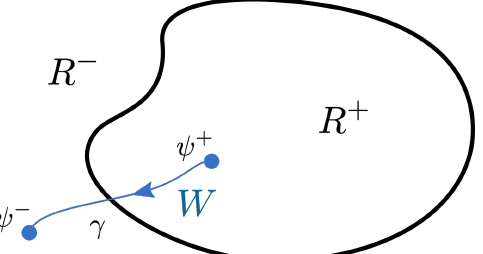
Figure 7: We consider the gluing of two regions R + and R − containing two charged (point) particles ψ + and ψ − connected by a Wilson line γ . In Σ , the observable W (152) is gauge invariant. Nonetheless, its gluing is ambiguous in the presence of a regional stabilizer (153). This ambiguity is closely related to ’t Hooft’s beam splitter thought experiment and highlights the fact that global phase transformations (which are part of the stabilizer) are physical transformations distinguished from pure gauge transformations. Our formalism allows to make this distinction also within a finite and bounded regional, i.e. at the